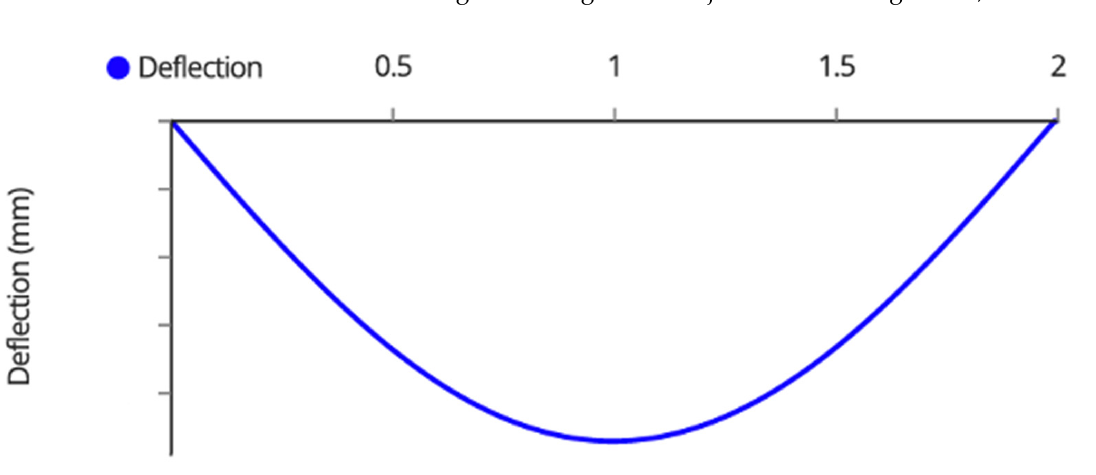
Figure A3. Joist Bending Moment Diagram.